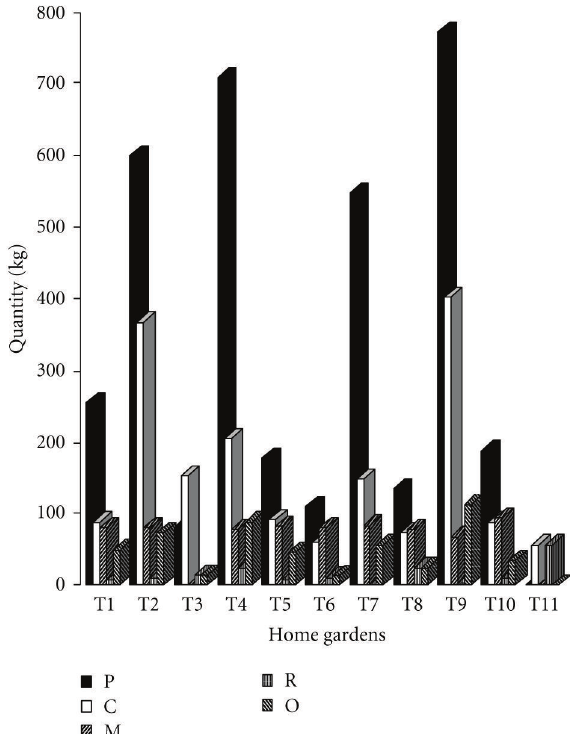
Figure 3: Banana annual flow in 11 agroforests (Type 1, 2, ... , 11): production (P), consumption (C), marketing (M), reception (R), and o ff ers